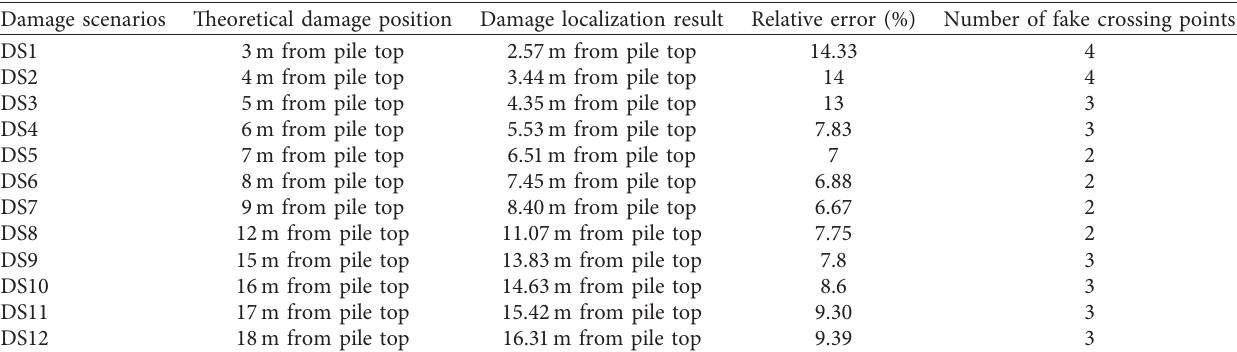
Table 3: Damage localization results under different damage